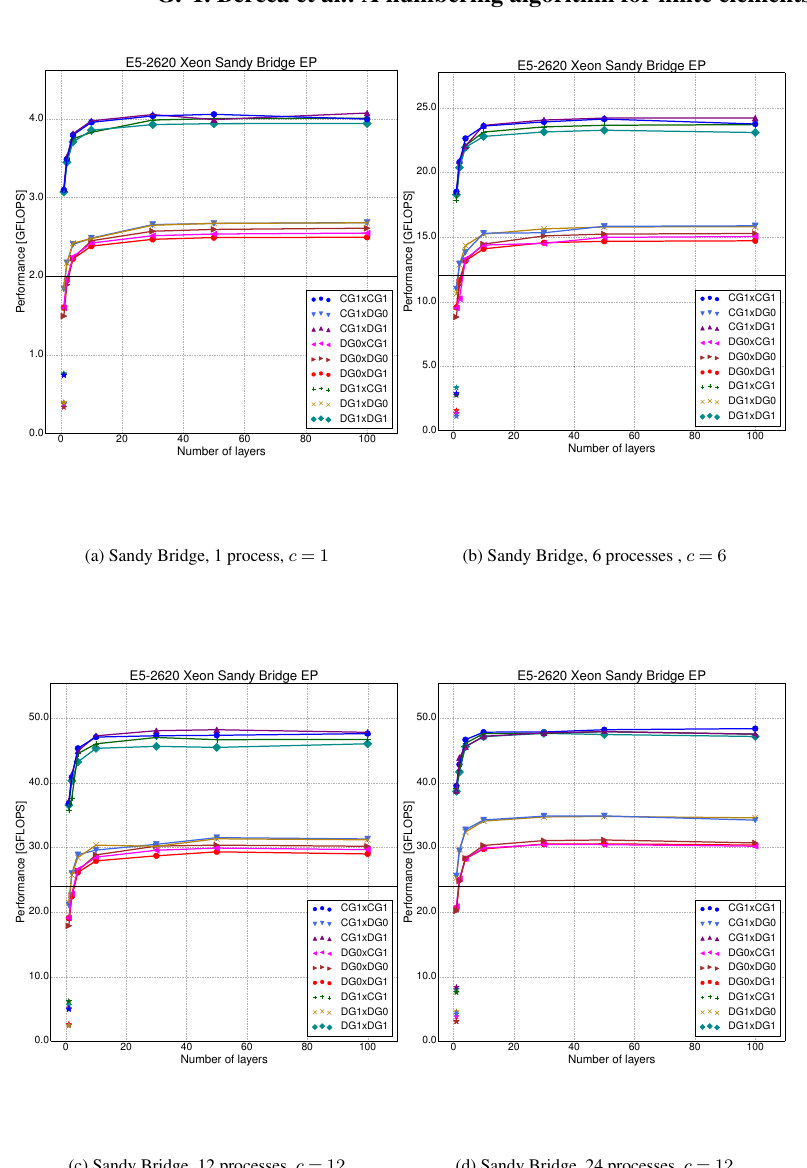
Figure 7. Performance of the I integral computation with a varying number of layers and number of processes on a well-ordered base mesh. The star-shaped markers show the performance of the one-layer badly ordered mesh for comparison. The horizontal line is the base FLOP throughput for f b = f v = 1 and the number of physical cores used.